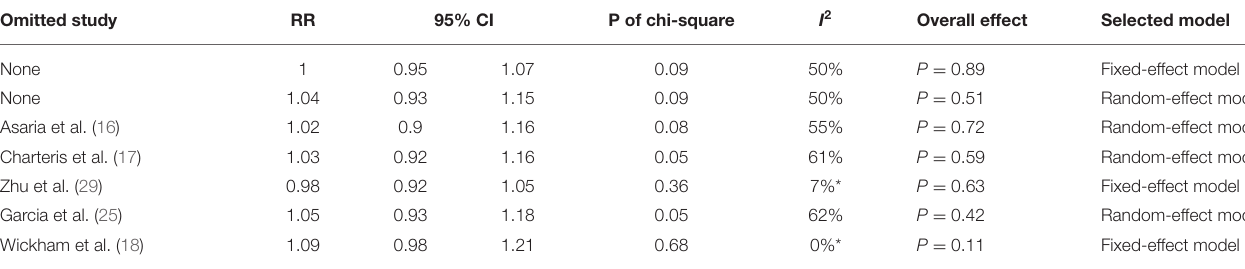
TABLE 3 | Sensitivity analysis for main outcome: primary success at 6 months.